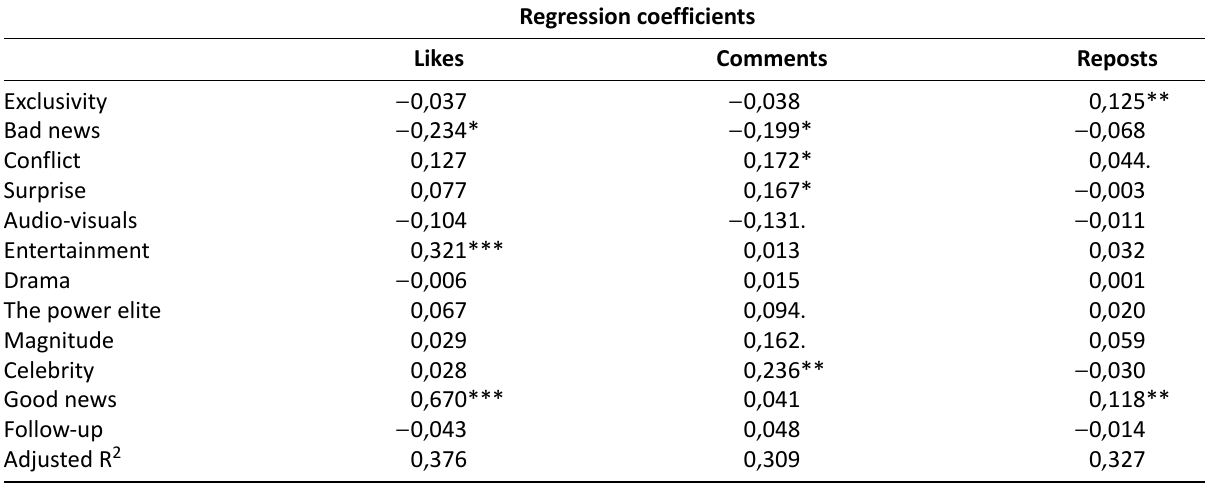
Table 3. Multiple regression models testing news values for likes, reposts and comments: State-owned media.